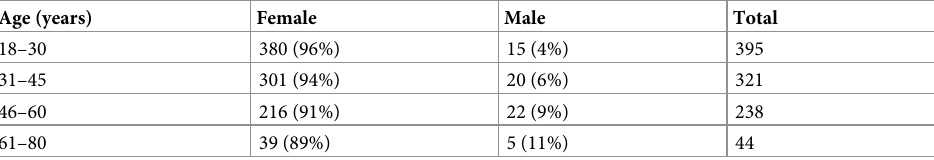
Table 1. Respondents’ age in years and gender. Values in parentheses are row percentages.